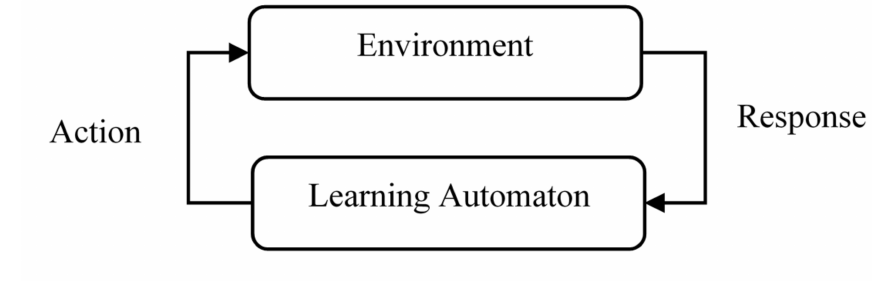
Figure 1. Learning automaton and the